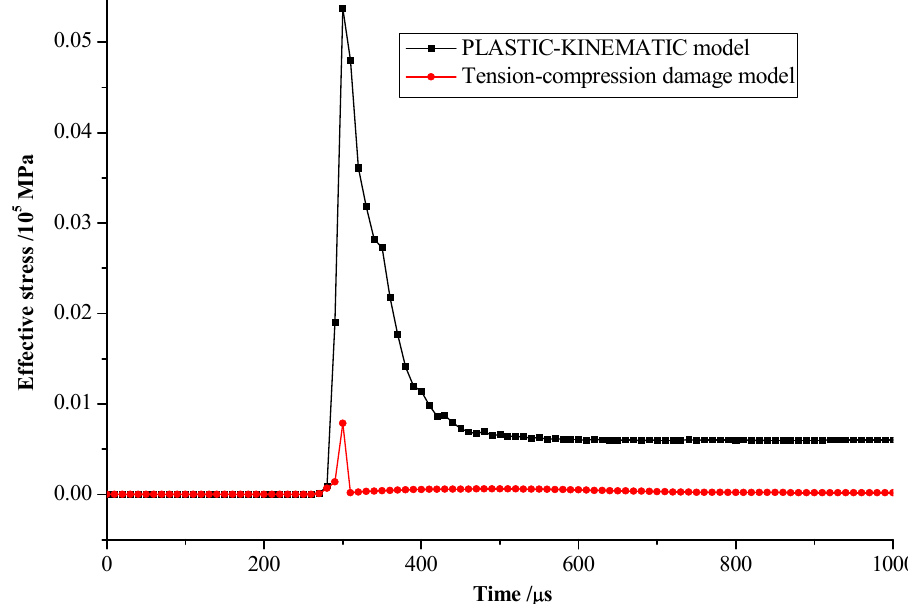
Figure 3. Effective stress-time curves for monitoring point 1.